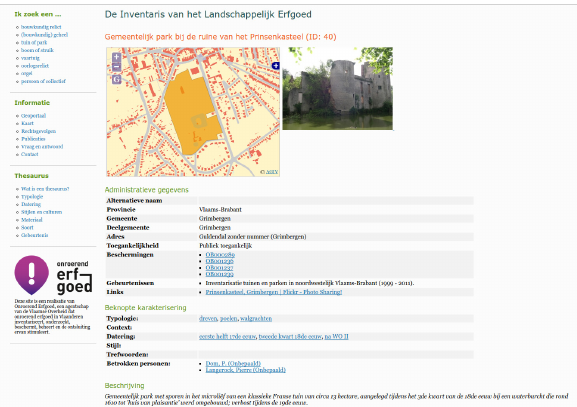
Figure 2: The inventory of historical parks and gardens, 2015.